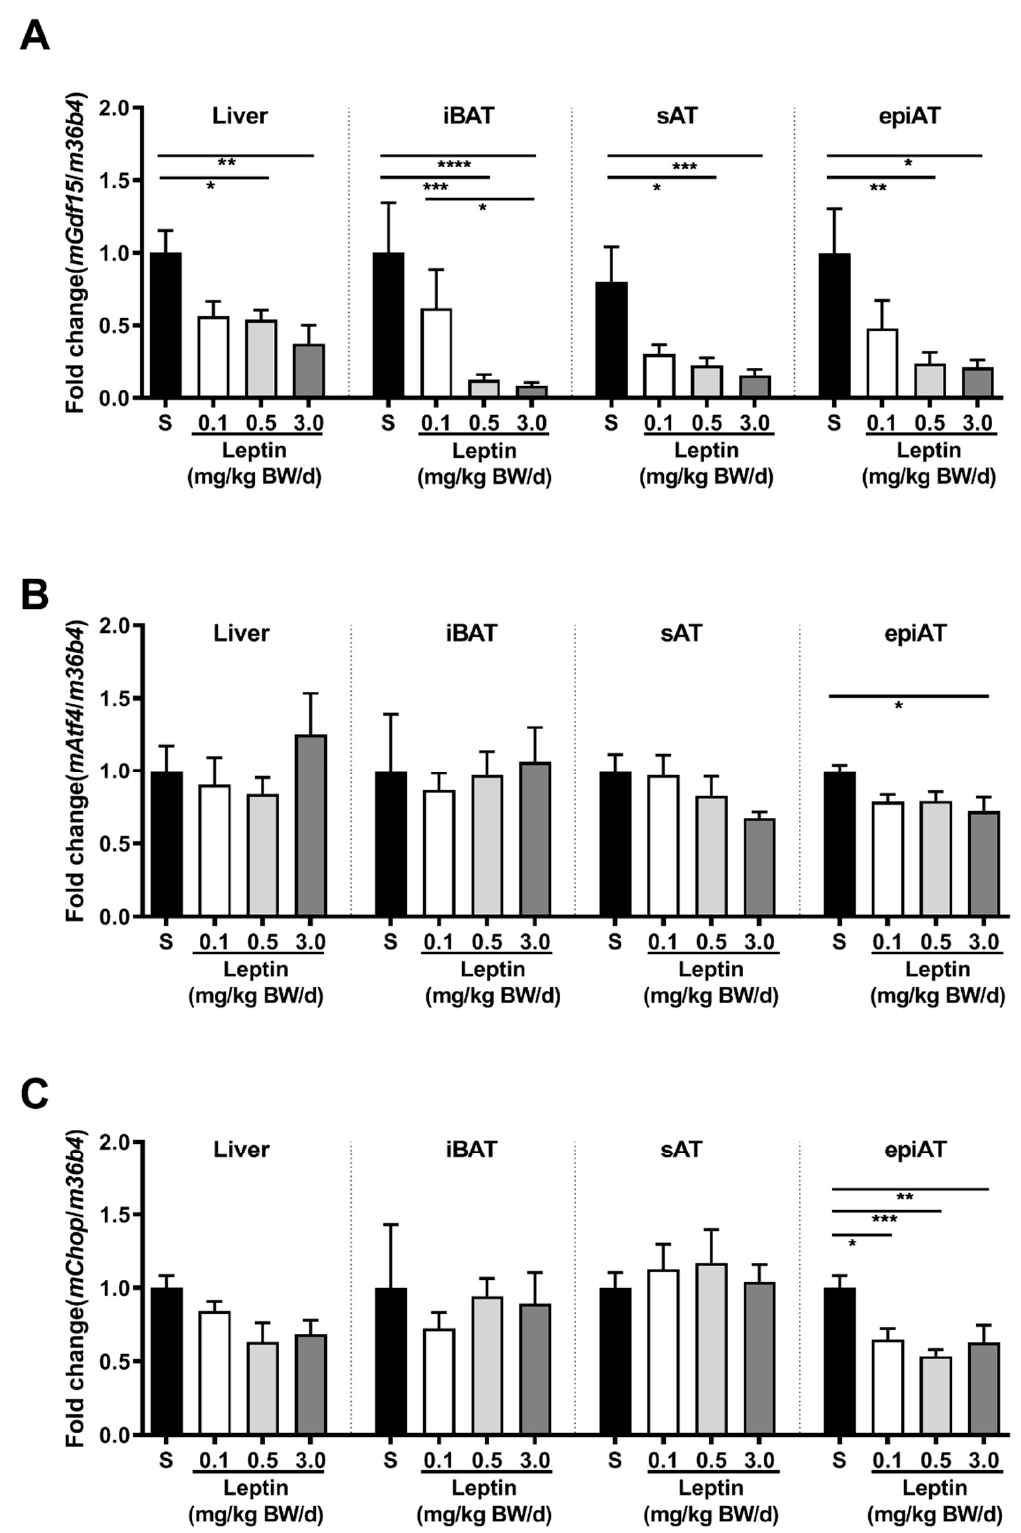
Figure 2. Effect of leptin treatment (0.1, 0.5, and 3.0 mg/kg BW/d) on Gdf15 ( A ), Aft4 ( B ), and Chop ( C ) mRNA expression relative to 36B4 ( n ≥ 8 per group) in liver, intrascapular brown (iBAT), subcutaneous (sAT), and epididymal (epiAT) adipose tissue of LDLR-/-; ob/ob animals. Data are presented as means ± SEM. Differences were assessed by one-way ANOVA corrected by Bonferroni–Holm. * indicates p < 0.05, ** p < 0.01, *** p < 0.001, **** p < 0.0001.